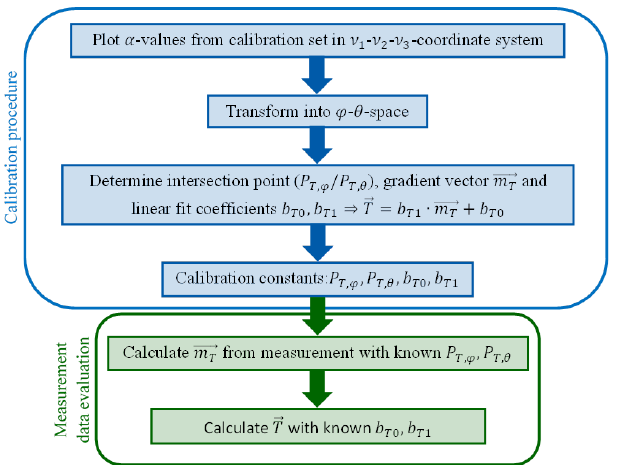
Figure 9. Schematic of calibration procedure (blue box) and subsequent measurement data evaluation (green box) for temperature evaluation. Concentration evaluation is performed in the same manner.